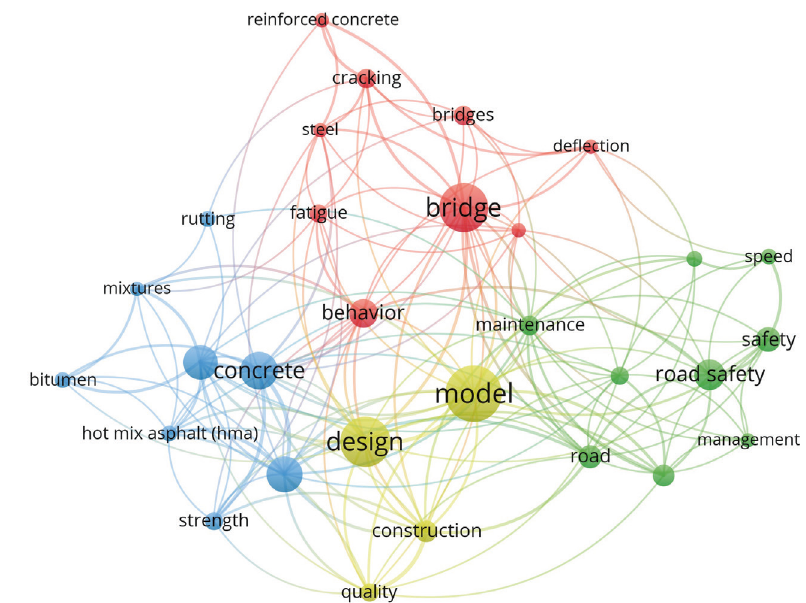
Figure 9. All keyword co-occurrence network of the Baltic Journal of Road and Bridge Engineering